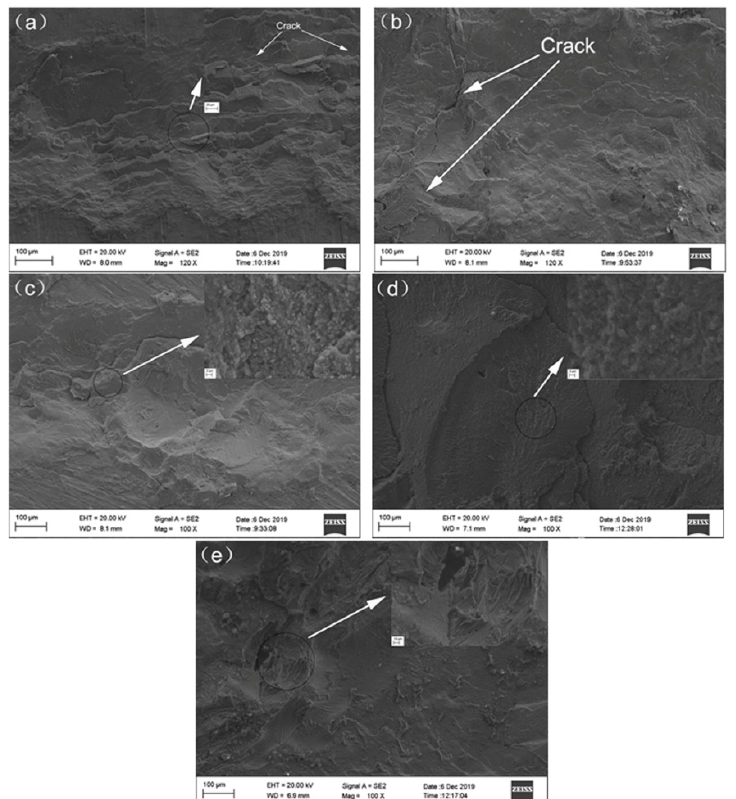
Figure 8. Shear strength of the different welded joints.